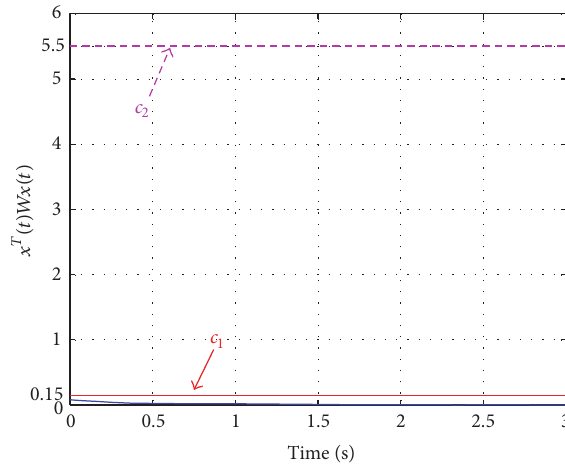
Figure 2: State response of the closed-loop system.